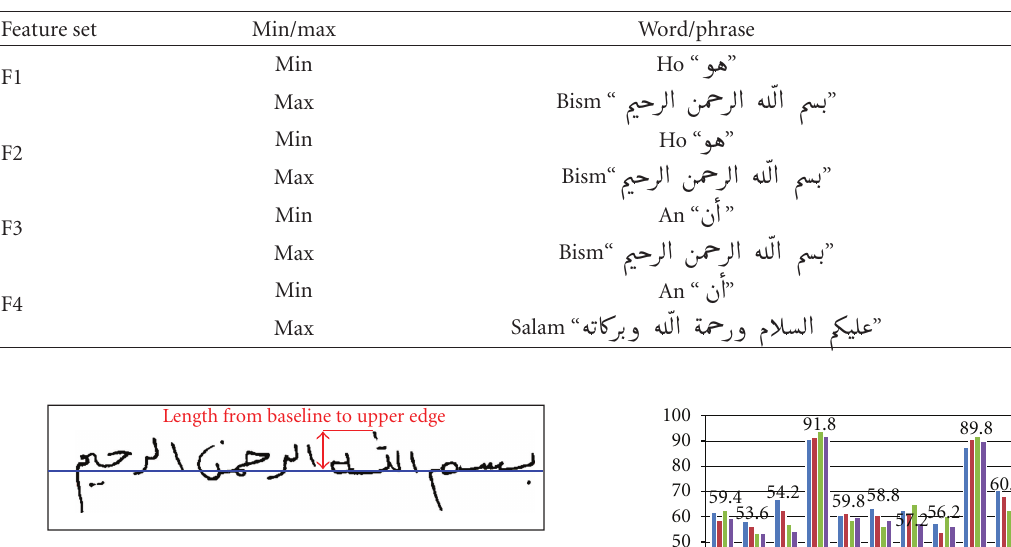
Figure 9: Measuring the length from the baseline to the upper edge.